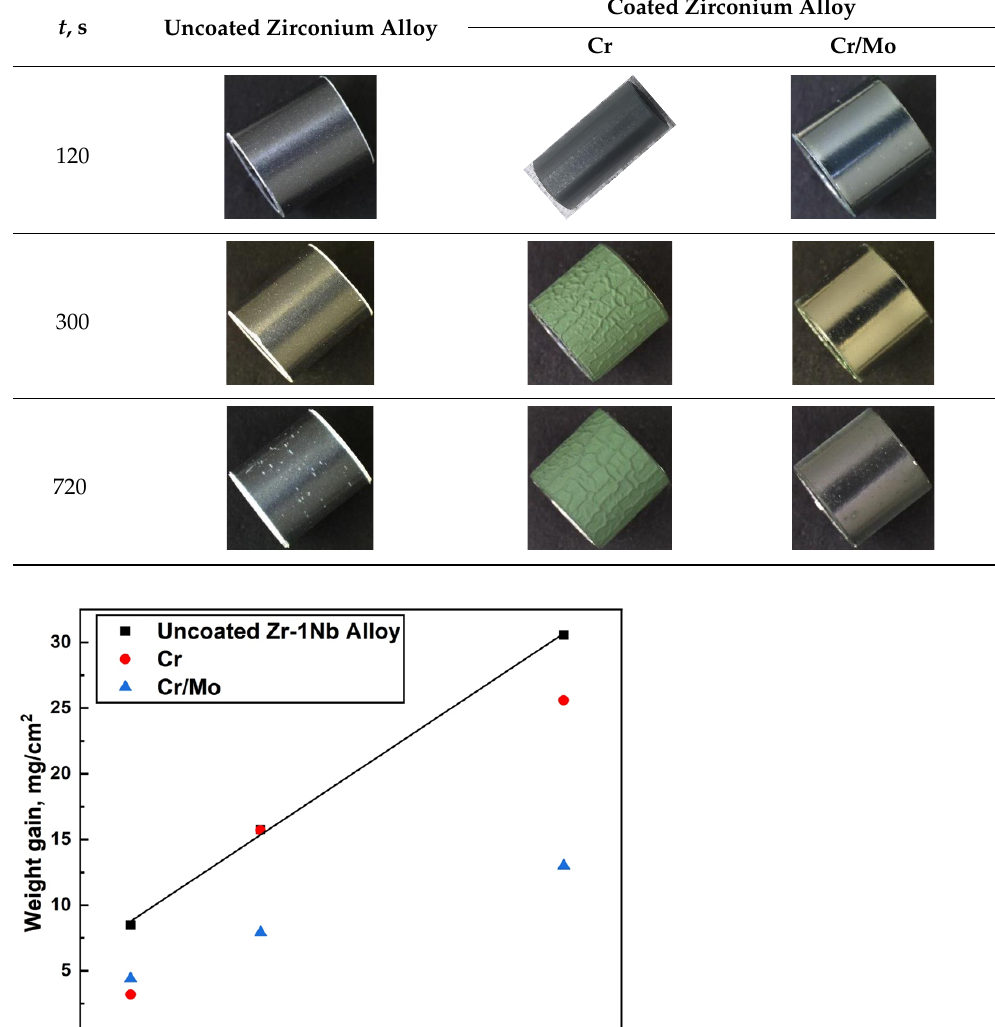
Table 3. The outer view of the samples after oxidation at 1330 °C.